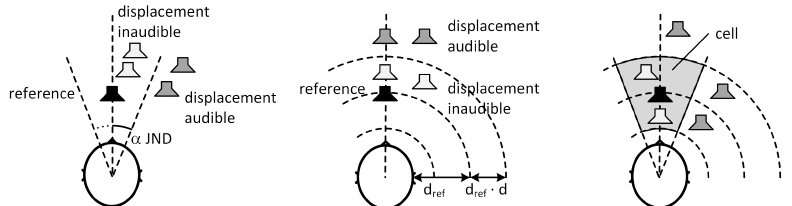
Figure 3. Localization blur ( left ), distance blur ( middle ), and assembled cell ( right ) in the horizontal plane. A displacement of the reference (black speaker symbol) by an angle or distance below the threshold is inaudible (light gray symbols), whereas a bigger displacement is audible (dark gray symbols). An area or cell is formed where no displacement is audible (after